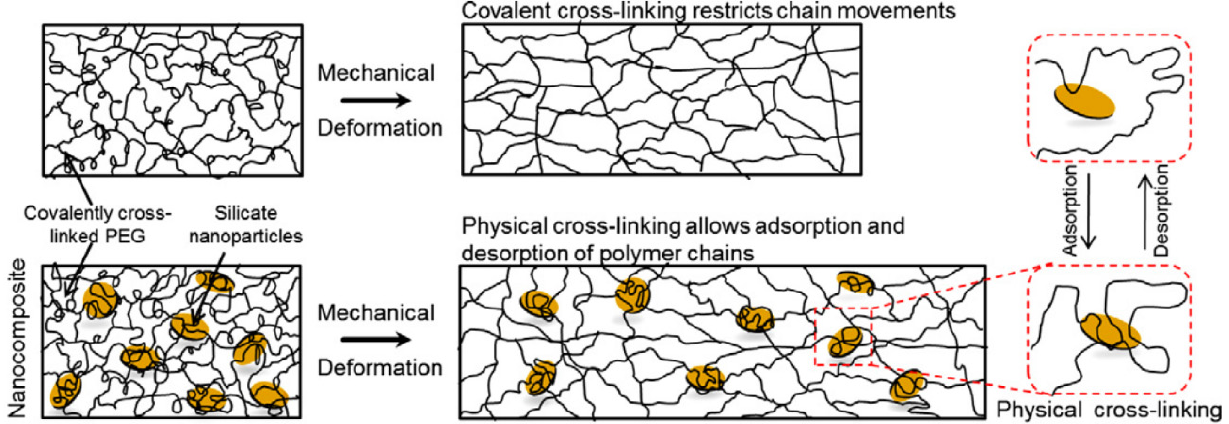
Figure 13 . Effect of clay incorporation on the mechanical properties of the PEG network. Mechani- cally strong and highly elastomeric hydrogels resulted from covalent cross-linked polymeric chains and physical cross-linking between silicate nanoparticles and polymeric chains. (Reprinted with permission from [65]. Copyright 2015, Elsevier).